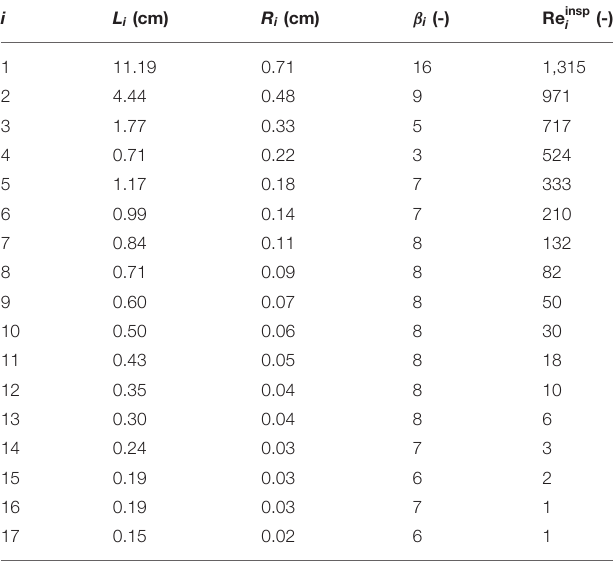
TABLE 2 | Morphometric data, scaled to yield a functional residual capacity of 3 l (Karamaoun et al.,